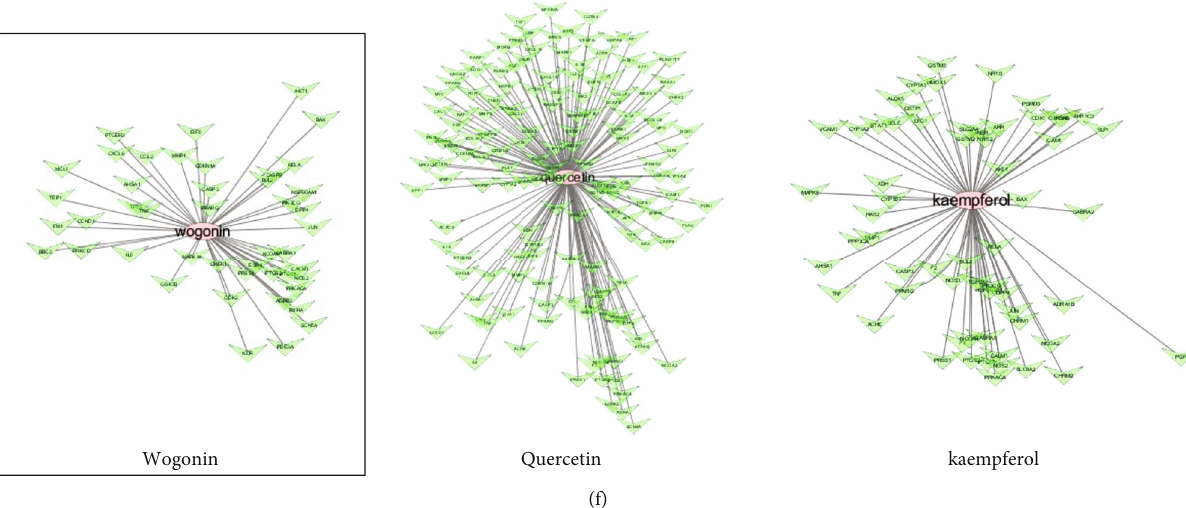
Figure 2: Network pharmacology analysis of HQGZ formula in discogenic LBP. (a) There were 257 potential therapeutic targets in the HQGZ formula for discogenic LBP. (b) A total of 9 MCODE networks were constructed using PPI enrichment analysis of the 257 therapeutic targets. Di ff erent colors represent di ff erent MCODE networks. (c) GO enrichment analysis of 257 therapeutic targets (colored according to p values). (d) KEGG enrichment analysis of 257 therapeutic targets (colored according to p values). (e) Active ingredients and target networks of the HQGZ formula. Red ovals represent active ingredients and green triangles represent targets. (f) The analysis of potential therapeutic candidates (i.e., wogonin, quercetin, and kaempferol) assumed to be the most likely bioactive chemical components of the HQGZ formula for discogenic